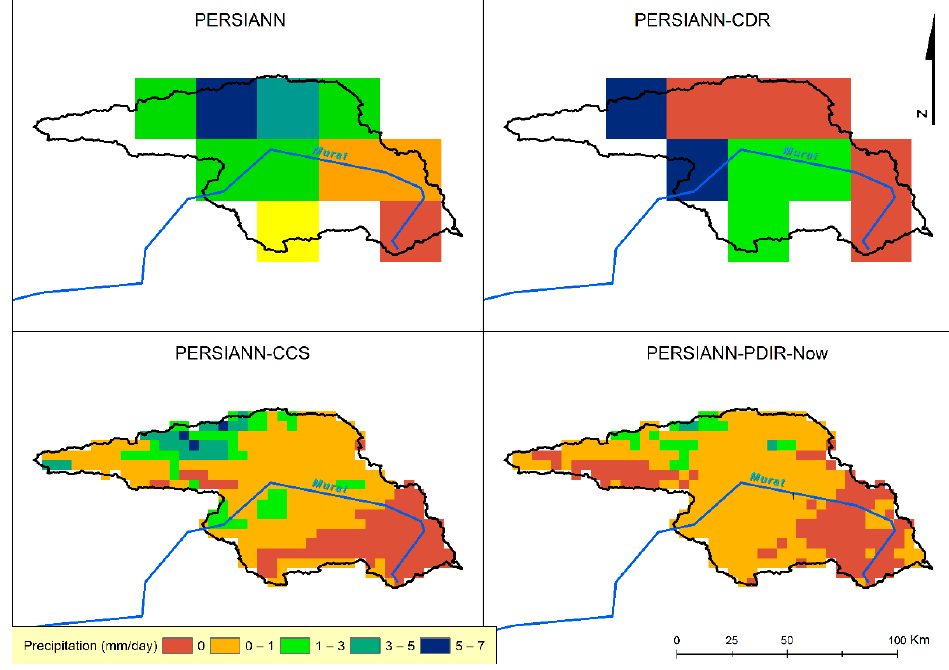
Figure 4. SBP distribution across the study area for 05-Jan-2015.